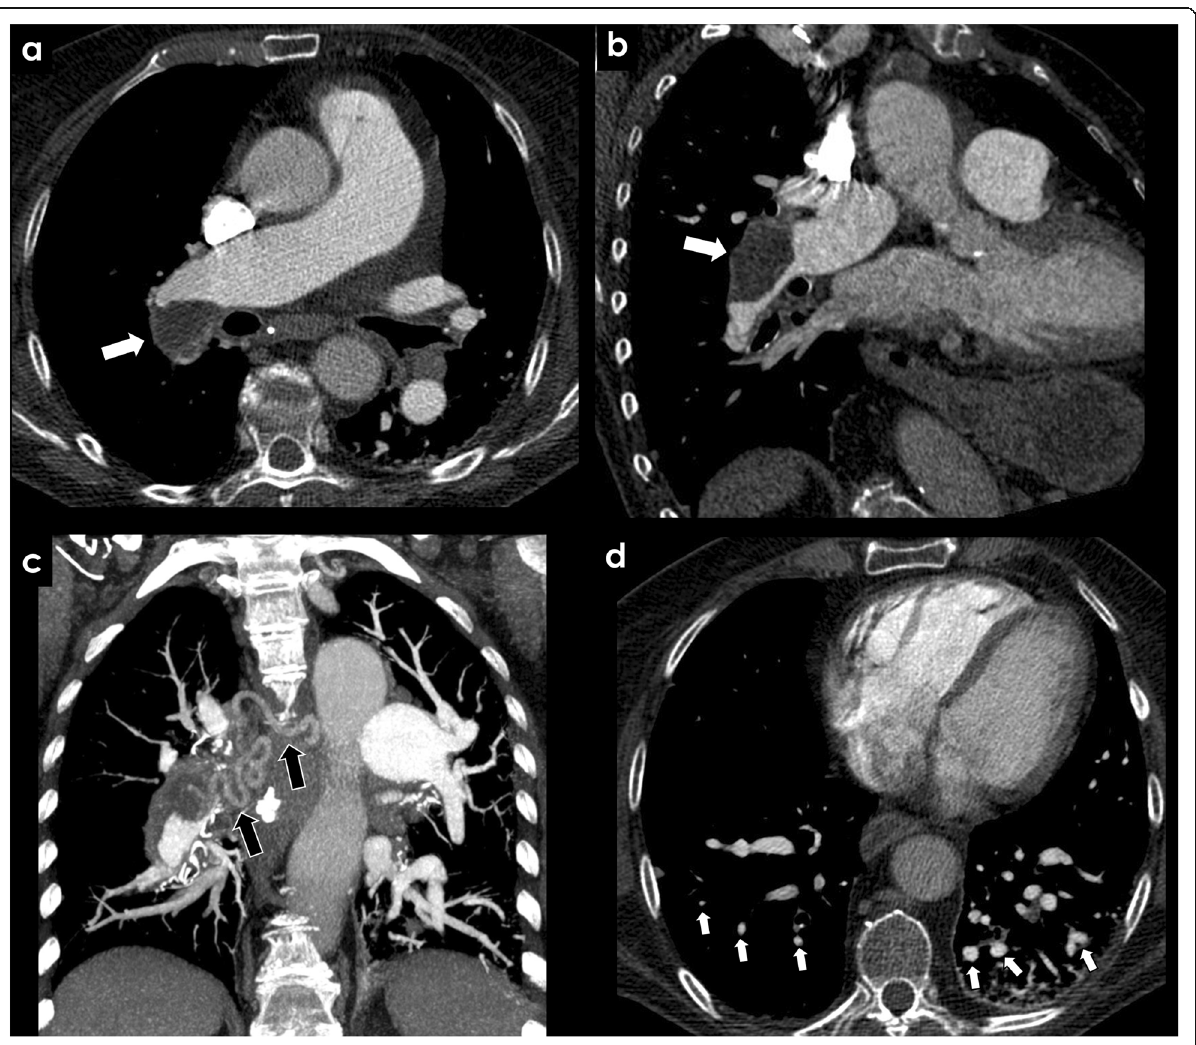
Fig. 10 Acquired causes of BAH — chronic thromboembolic disease. CECT findings in a patient with history of chronic thromboembolic disease. A peripheral filling defect with obtuse margins is seen in the right pulmonary artery ( a , b ; white arrows), with an asymmetric caliber of distal vessels ( d , white arrows) and a significant right bronchial artery hypertrophy ( c , black